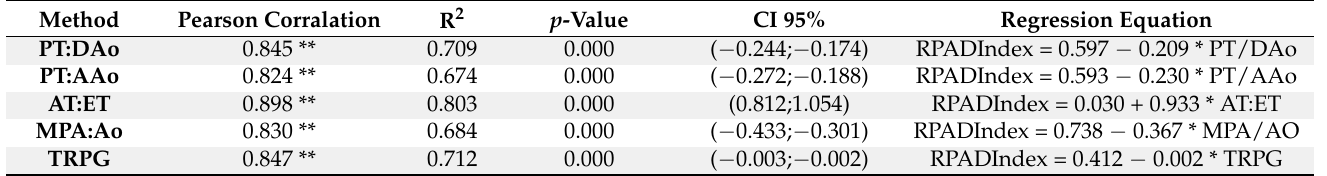
Table 3. Sensitivity (Se), specificity (Sp), and Youden index of cut-off points of the studied parame- ters/measures to predict PH estimate based on the right pulmonary artery distensibility index (RPAD index) <